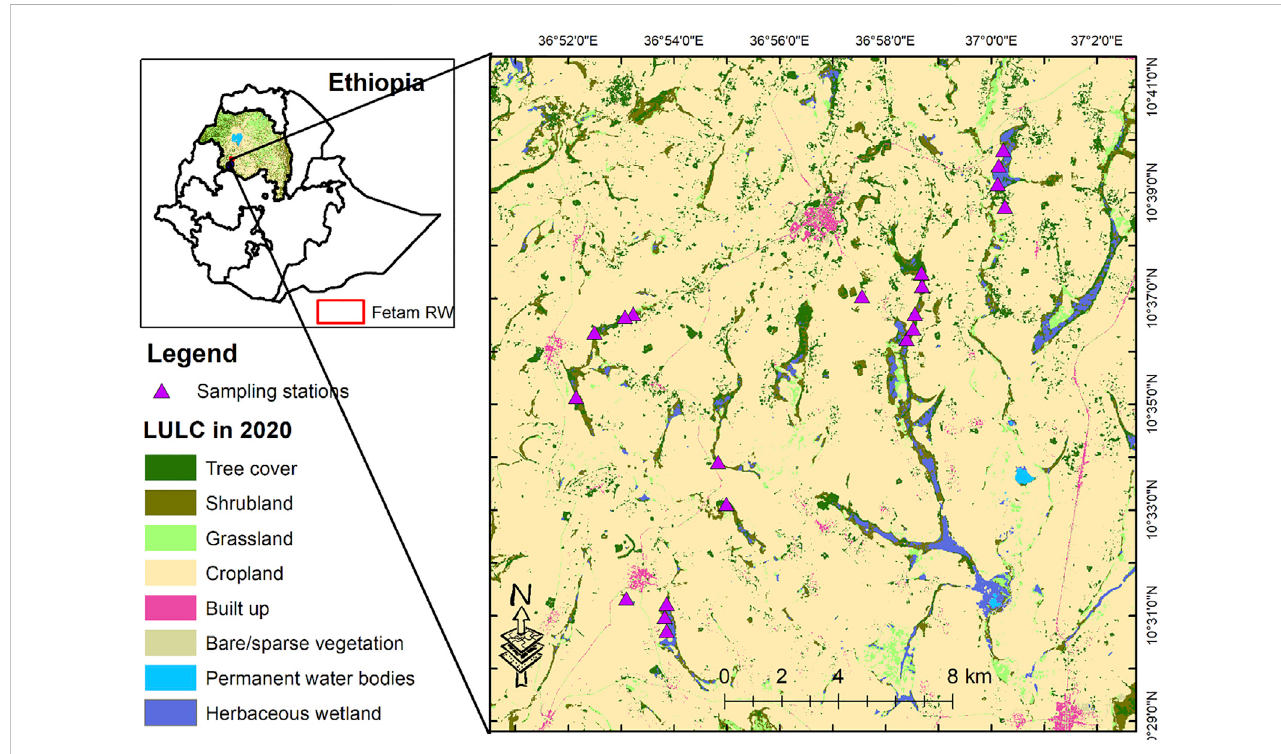
FIGURE 1 The location of the study area and wetland sampling stations in the Fetam River watershed, Upper Blue Nile basin, northwestern